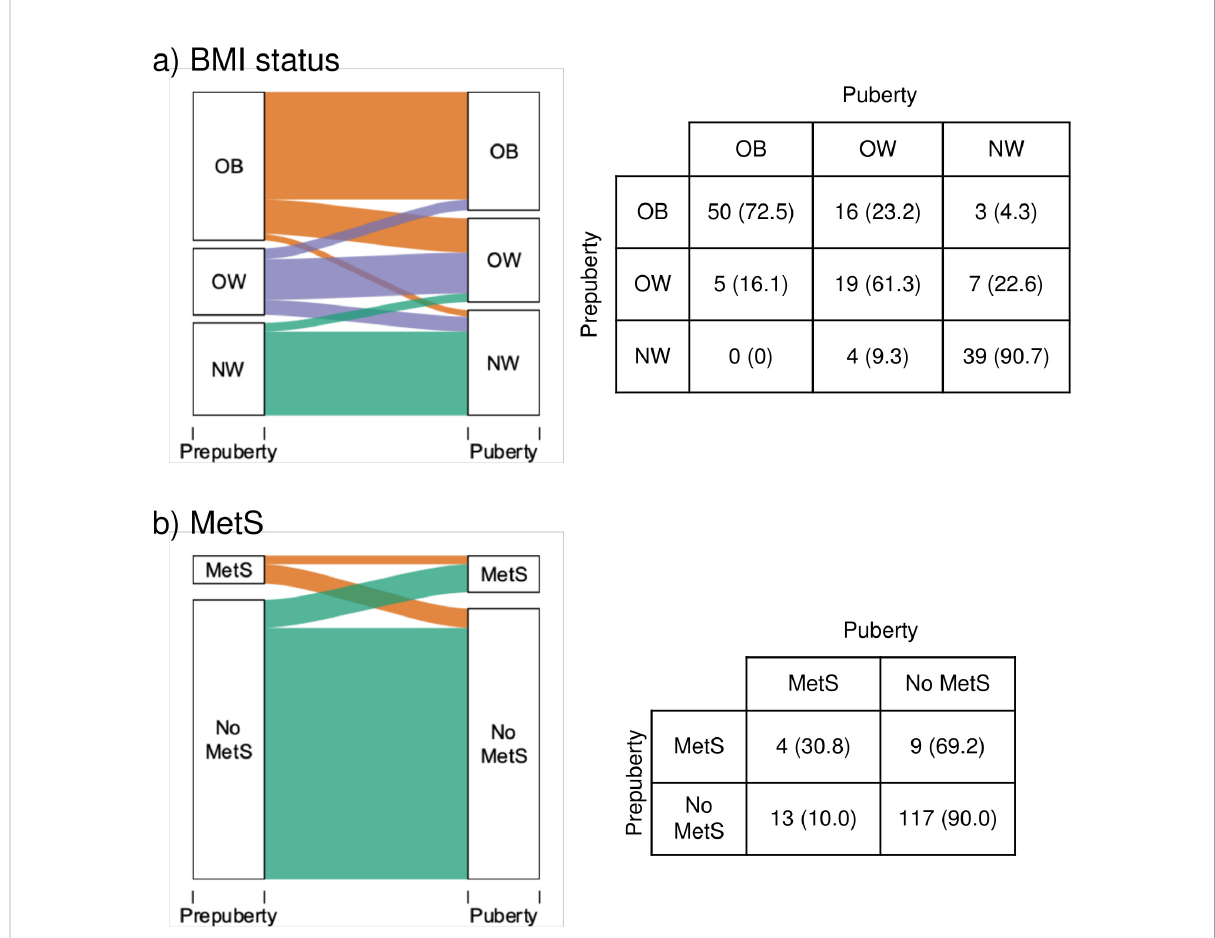
FIGURE 1 Progression from prepuberty to puberty of (A) BMI status and (B) prevalence of metabolic syndrome. Statistics presented: n (%). OB, Obesity: OW, Overweight: NW, Normal weight: MetS, Metabolic